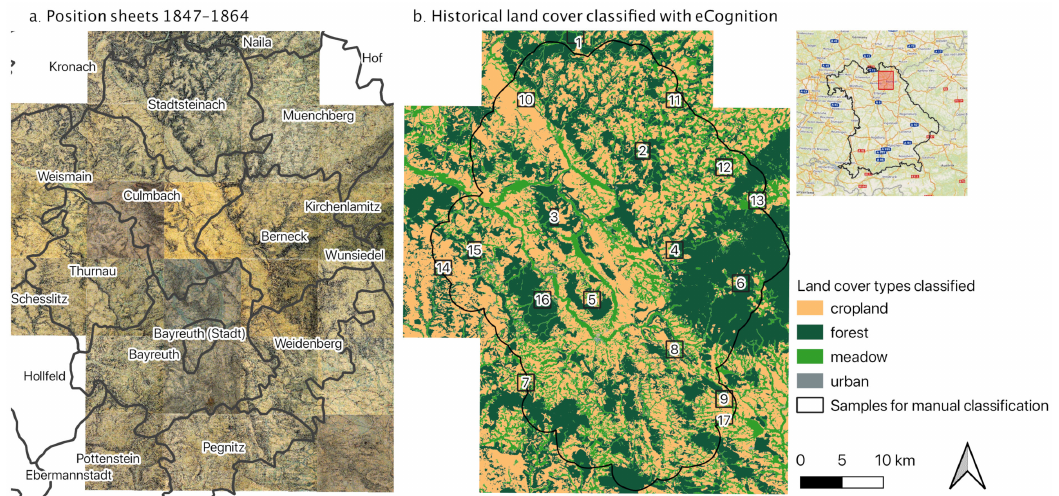
Figure 3. ( a ) Original position sheets (1:25,000, 1847–1864) with the borders of the police districts from 1879; and ( b ) automatically classified land cover with locations of 17 quadrants for manual reclassification. Table 3. (a). Historical land cover based on automatic classification broken down by police districts (see Figure 3a). (b). The 19th century cadastral statistics on land cover for the year 1853 [32]. Cropland Forests Meadows Urban Streets